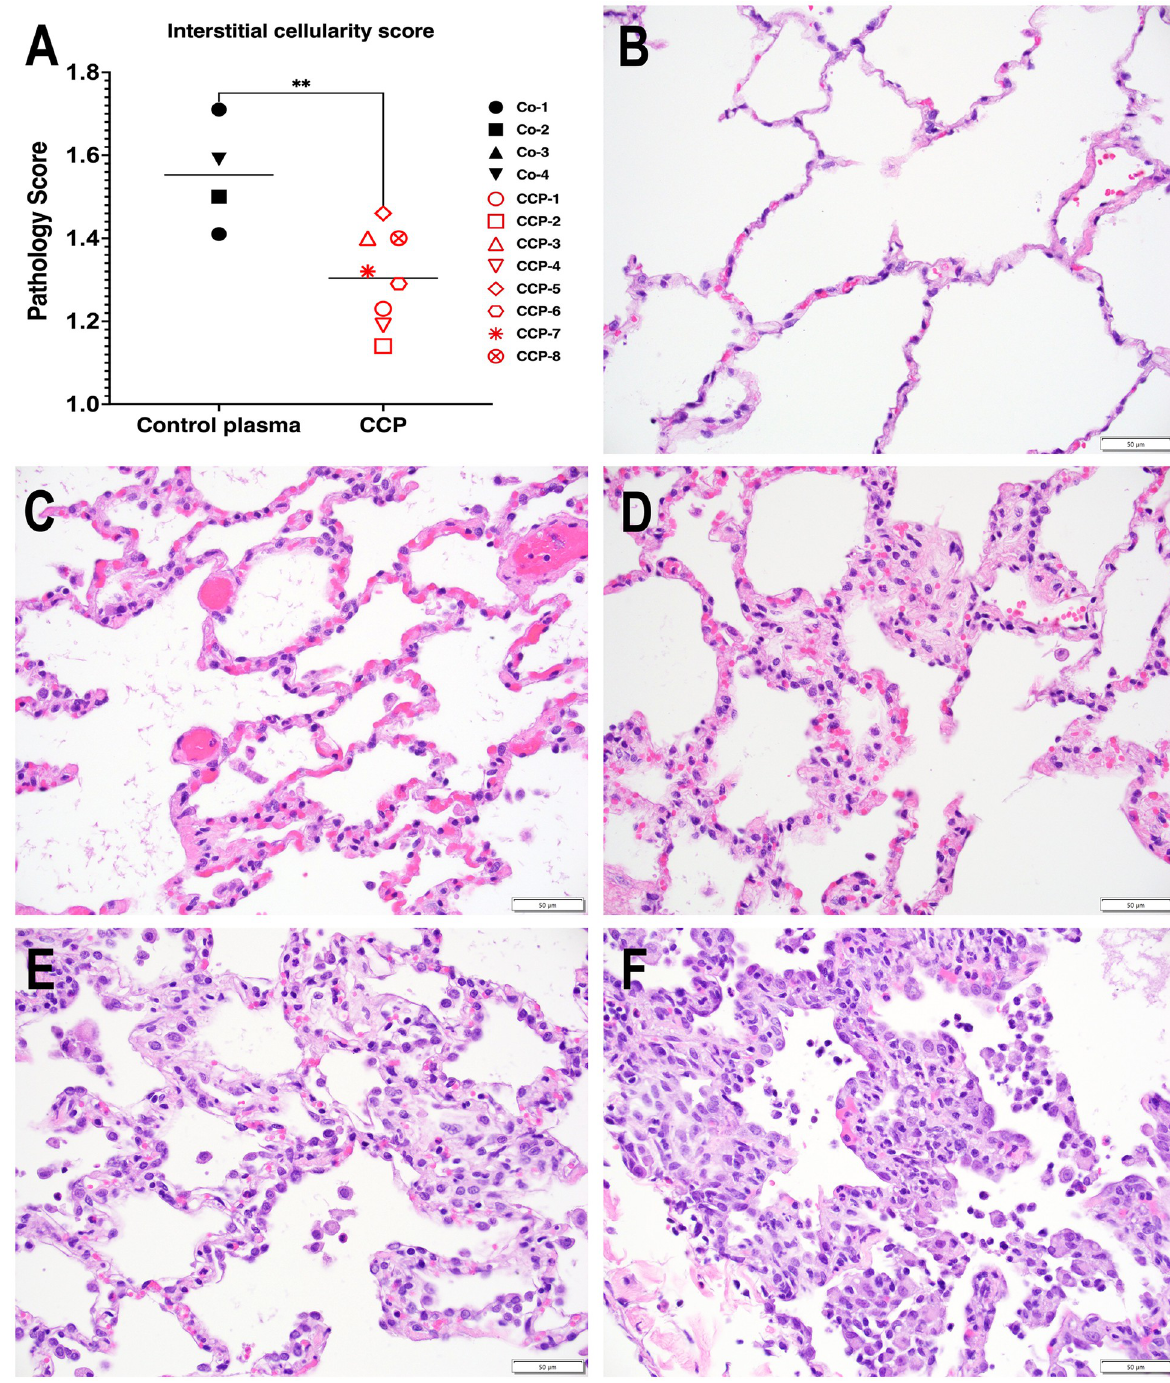
Fig 7. Reduced interstitial pneumonia in convalescent plasma-treated animals. A . Interstitial cellularity was evaluated on 7 lung lobes and an average score was tabulated as outlined in the Materials and methods section. Lines indicated mean values. The CCP group had significantly lower scores than the control group (p = 0.006; unpaired t-test). B-F . Interstitial cellularity score assigned to random x40 fields is based on the number of cells expanding the alveolar interstitium. Representative x40 images are shown. B . Grade 0: normal lung with thin acellular alveolar septae (animal CCP-7). C . Grade 1: alveolar interstitium expanded by 1 to 2 cells (animal CCP-1). D . Grade 2: alveolar interstitium expanded by 2 to 4 cells (animal CCP-1) E . Grade 3: alveolar interstitium expanded by 4 to 6 cells. (animal Co-3) F . Grade 4: alveolar interstitium expanded by more than 6 cells (animal